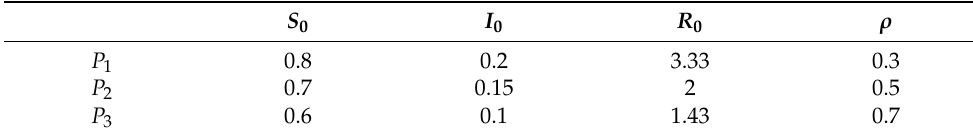
Table 1. Parameter values of each phase